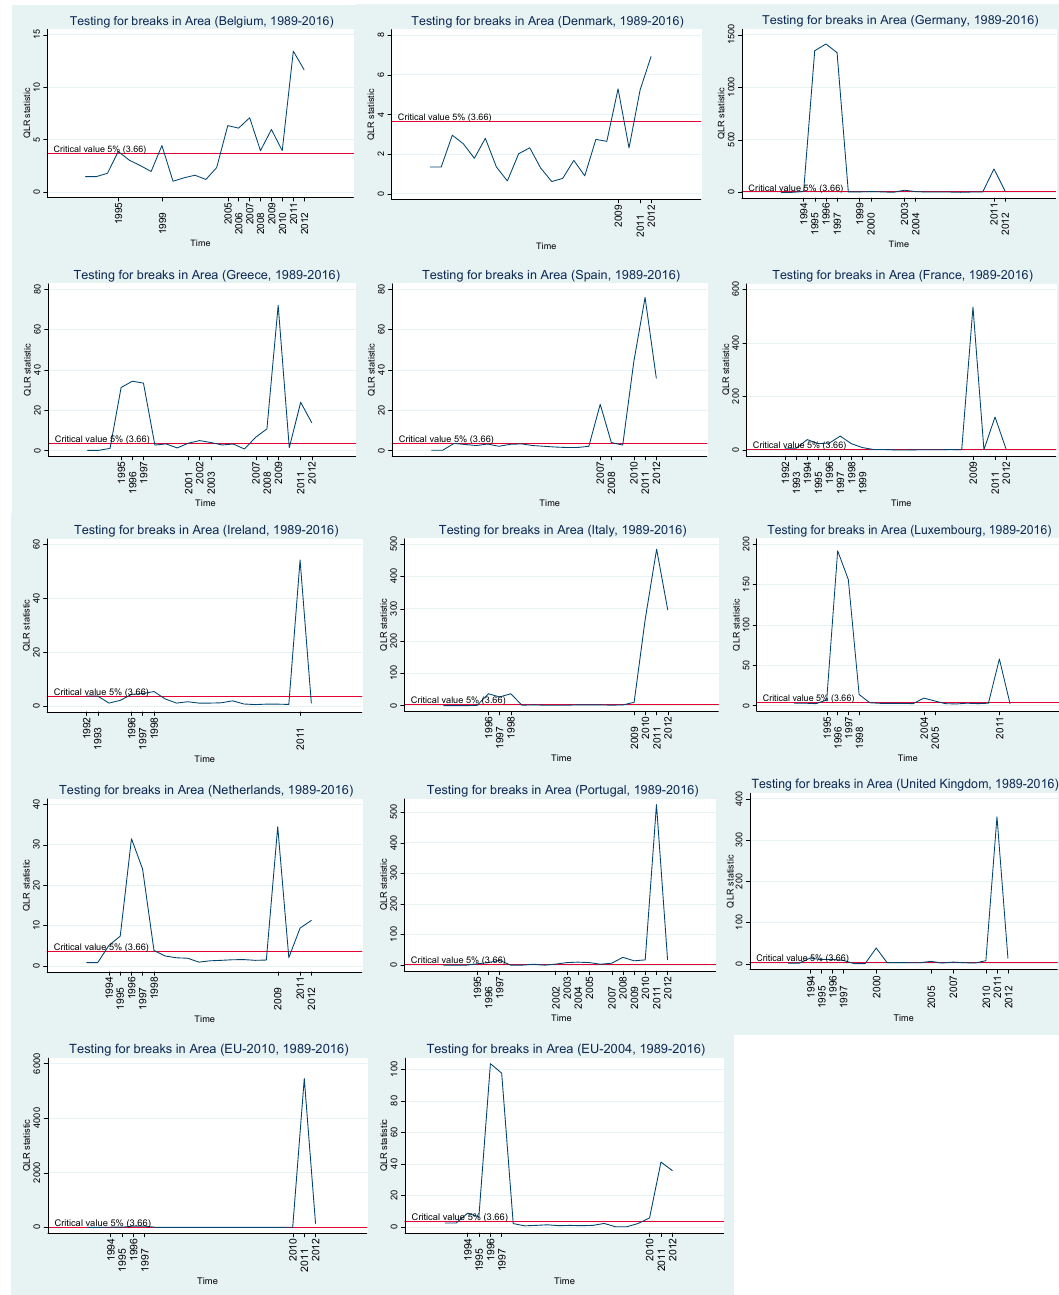
Figure 3. Testing for breaks in utilized agricultural area (hectares) over the European Union countries (1989–2016).